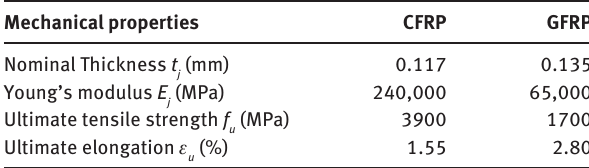
Table 1 Mechanical properties of fibers used in the FRP jackets. Table 2 Testing program.